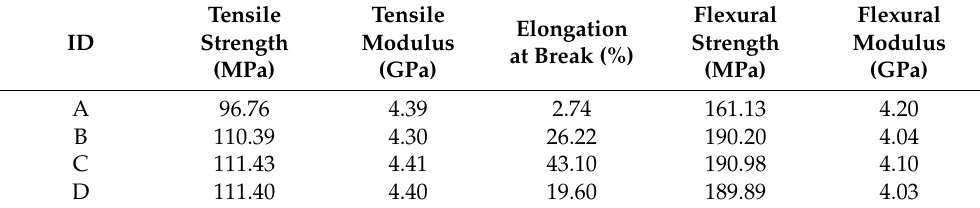
Table 2. Tensile and bending properties at different hot compression